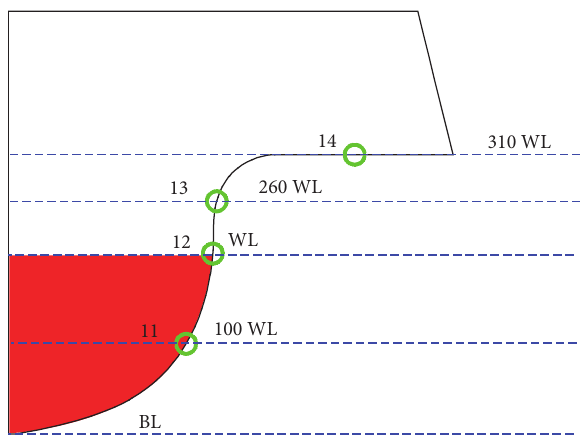
Figure 6: Pressure gauges arrangement